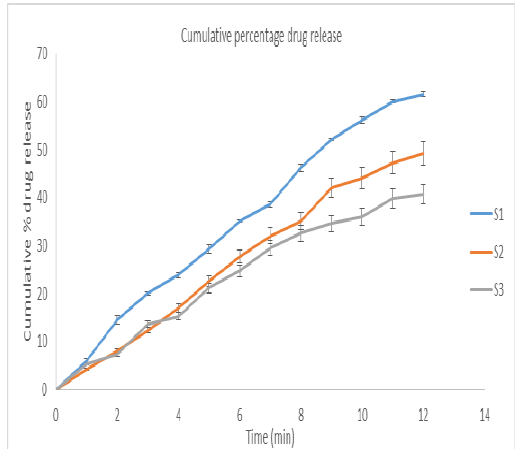
Figure 6. Drug release from S1 to S3